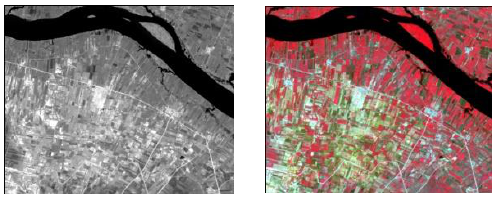
Figure 8: Spectral Response of radiometric targets after